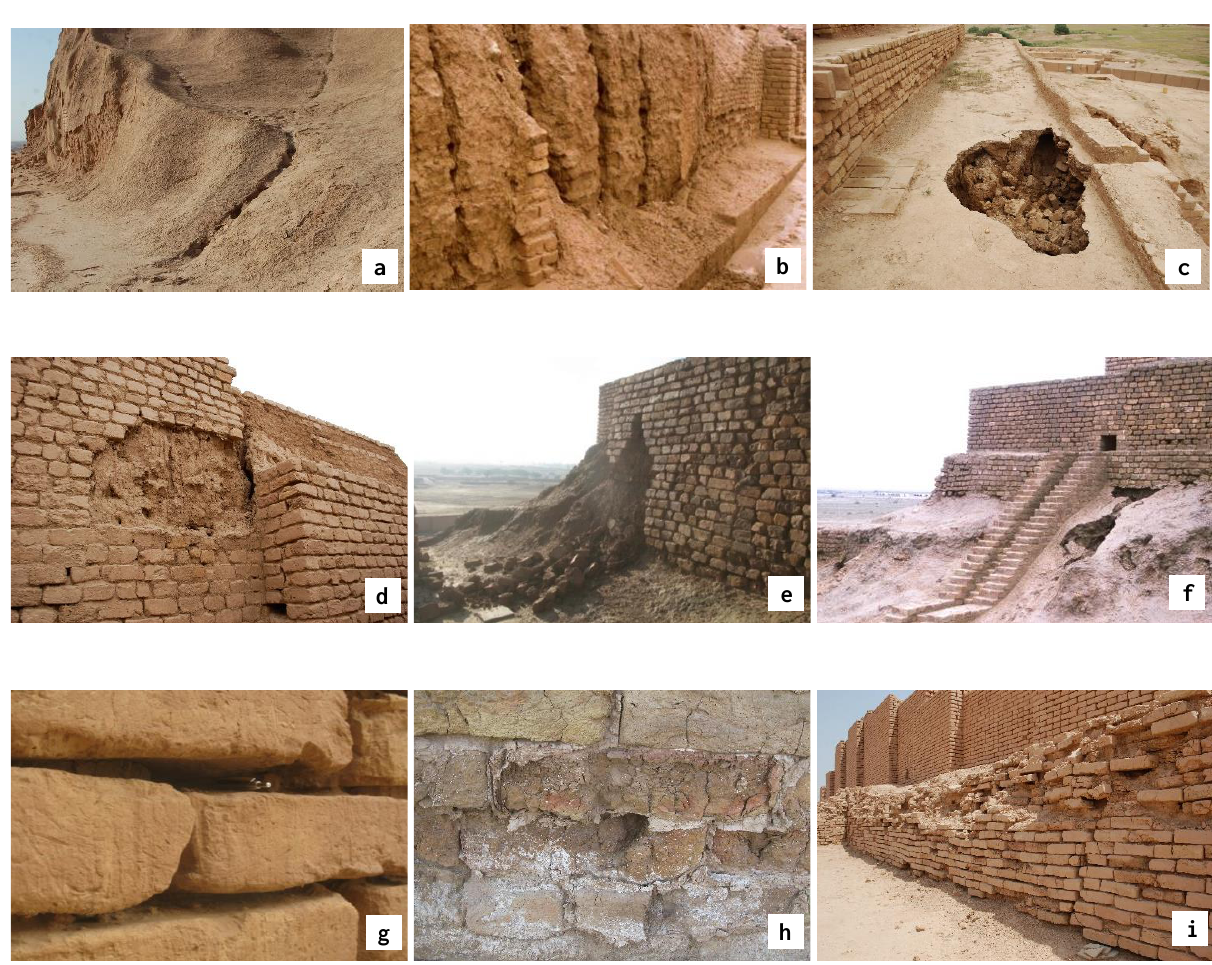
Figure 4. Different deterioration patterns caused by water: a) Rill erosion in the upper part of the ziggurat; b) Erosion of adobe structure as a result of scour (Archive of Tchogha Zanbil center); c) Soil subsidence in a second floor of the ziggurat; d) Detachment and collapse of the brick façade; e) Decay of inner adobe structure and collapse of the brick façade (Archive of Tchogha Zanbil center); f) cavities and erosion close to the gutter due to improper performance of the gutter (Archive of Tchogha Zanbil center); g) Loss of mortar in the brick façade; h) Salt efflorescence; i) Deformation and loss of the brick